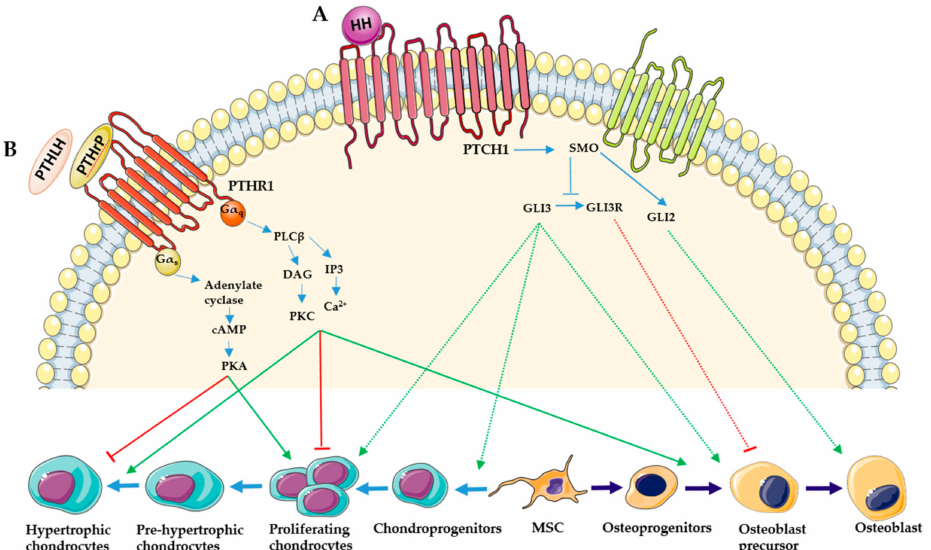
Figure 1. HH and PTHrP signaling pathways in chondrocyte and osteoblast differentiation ( A ) HH ligands interact with PTCH 1 receptor causing the activation of the SMO protein and in conse- quence, the activation of GLI transcriptor factors. HH signaling positively regulates the first steps of chondrogenesis from mesenchymal stem cells (MSC) and chondrocyte proliferation. It induces the specification of osteoblast precursors and the maturation in mature osteoblasts. The activation of the GLI3 repressor (GLI3R) inhibits osteoblast precursor proliferation. ( B ) PTHrP or PTHLH bind to PTHR1 activating G α s and G α q proteins. Through G α s, PTHrP activates adenylate cyclase and the production of cAMP, which in turn activates PKA proteins inducing chondrocyte proliferation and inhibiting their hypertrophic differentiation. However, through G α q, PTHrP activates PLC β and the production of DAG and IP3, leading to the activation of PKC and to an increase of intracellular Ca 2+ , respectively. PLC β signaling inhibits chondrocyte proliferation and induces their hypertrophic differentiation and osteoblast